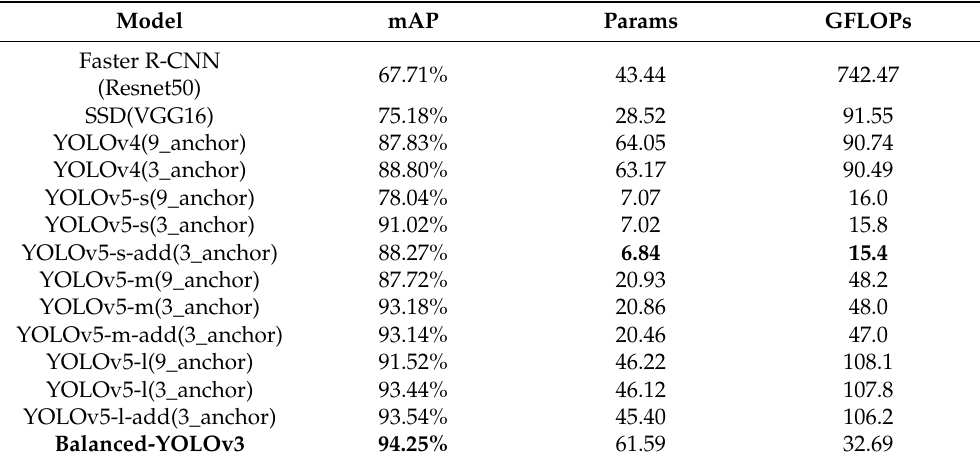
Table 7. Statistics of accuracy and complexity of eleven